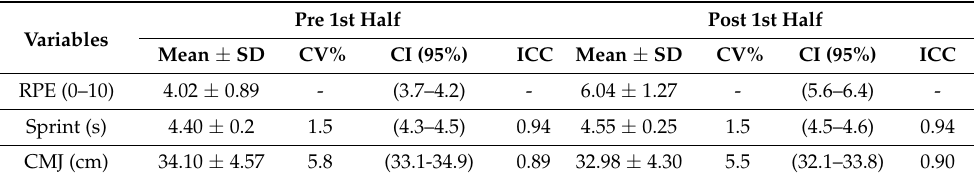
Table 1. Physical performance and reliability data obtained during the official matches.